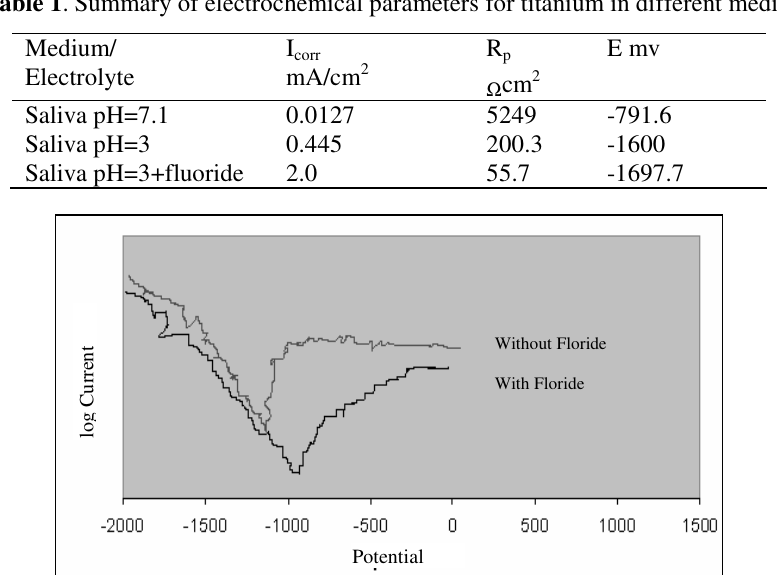
Figure 1 . Polarization curve after 1 h of immersion in media saliva pH 2 with and without